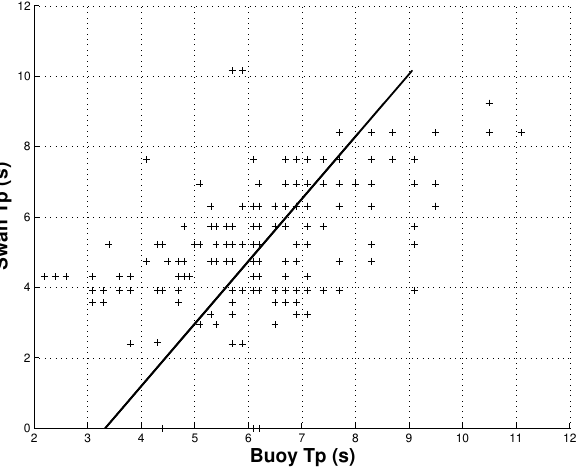
Fig. 12. Position of the regional grid (black boxes) and coastal grid